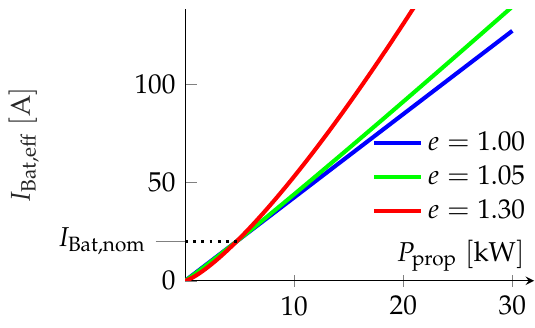
Figure 4. Consumption Characteristics for e = [ 1.00,1.05,1.30 ]